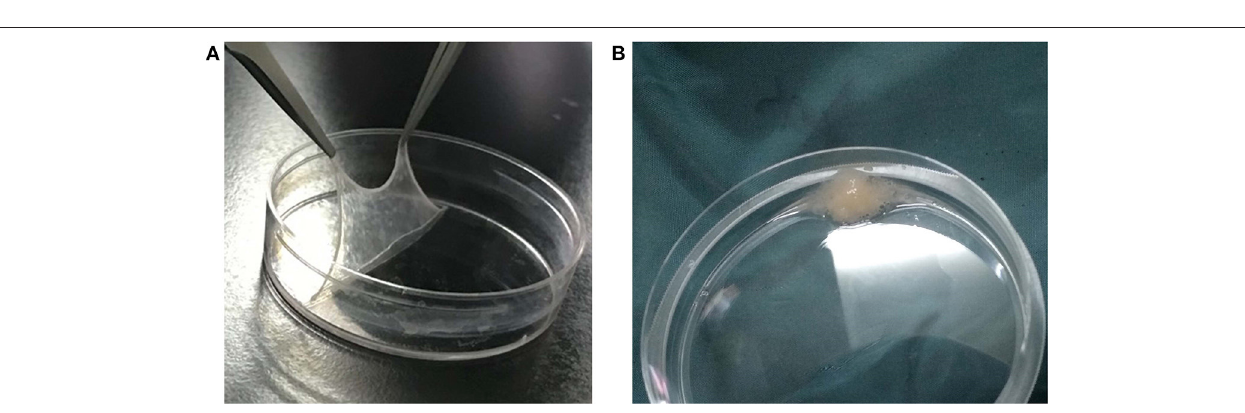
distracted for 5 days at a rate of 2.0 mm/d, once/d, and the total distraction length was 10 mm. A 3-D CT scan was performed